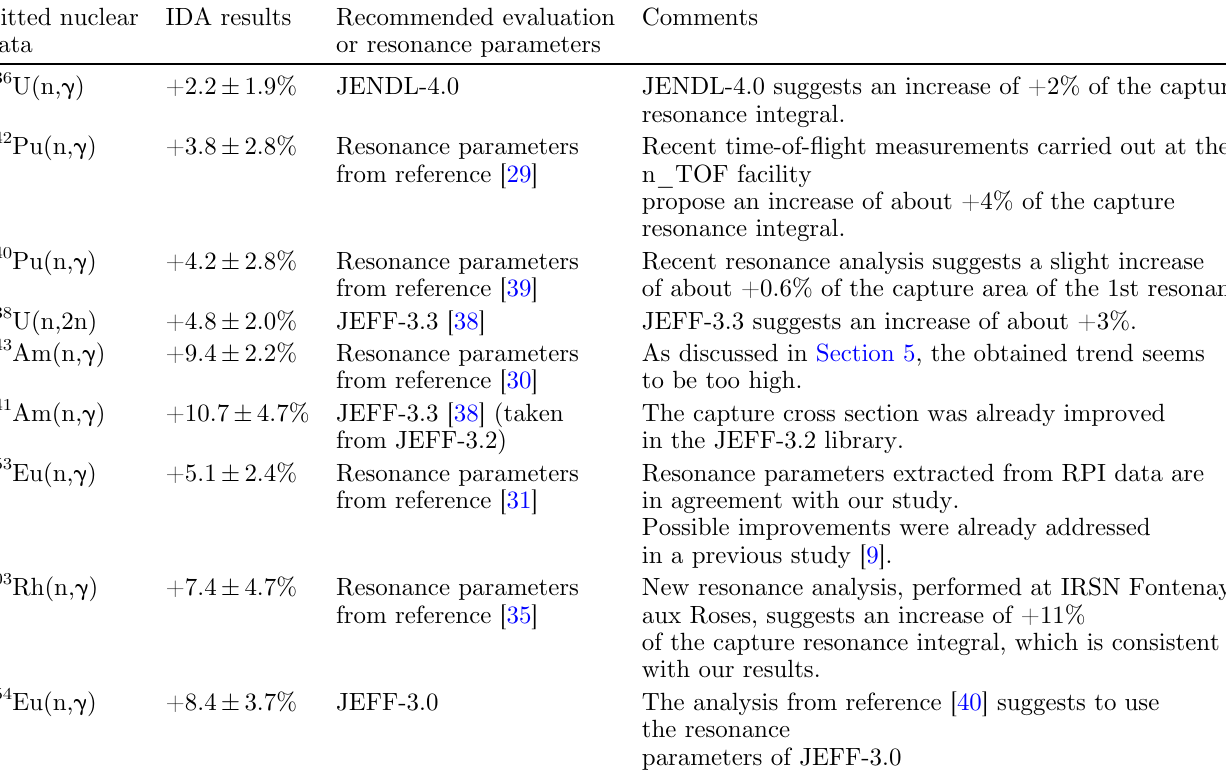
Table 7. Evaluated nuclear data fi les and new resonance parameters in agreement with the nuclear data adjustment trends provided by our Integral Data Assimilation